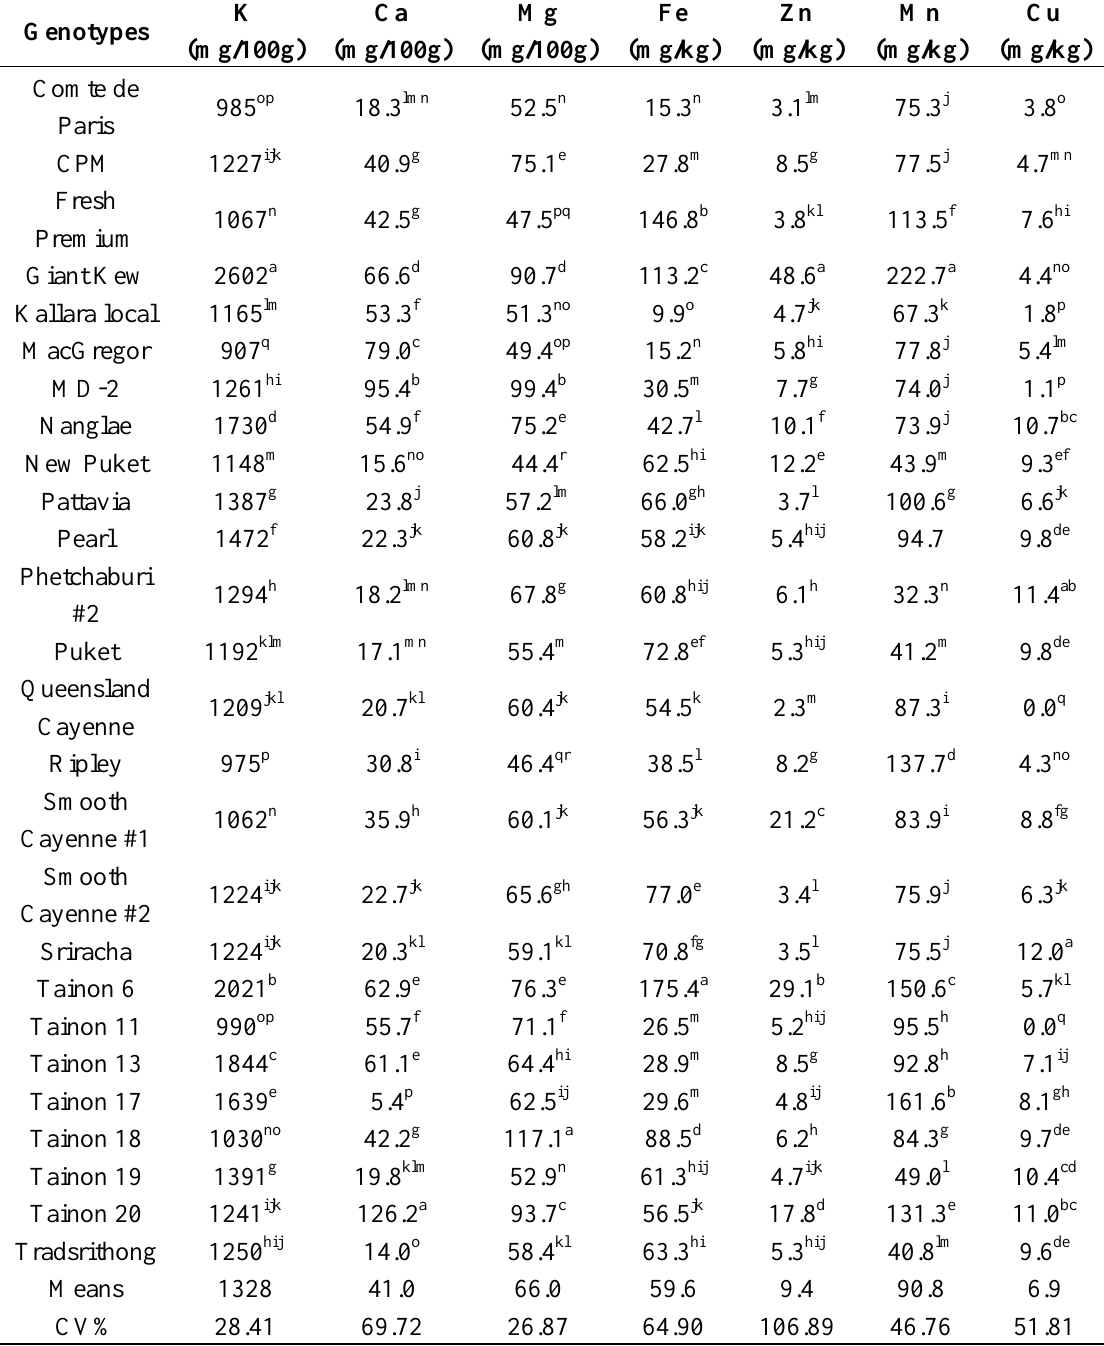
Table 5. Minerals of 26 pineapple genotypes from China referred to the dry matter (DM) content.